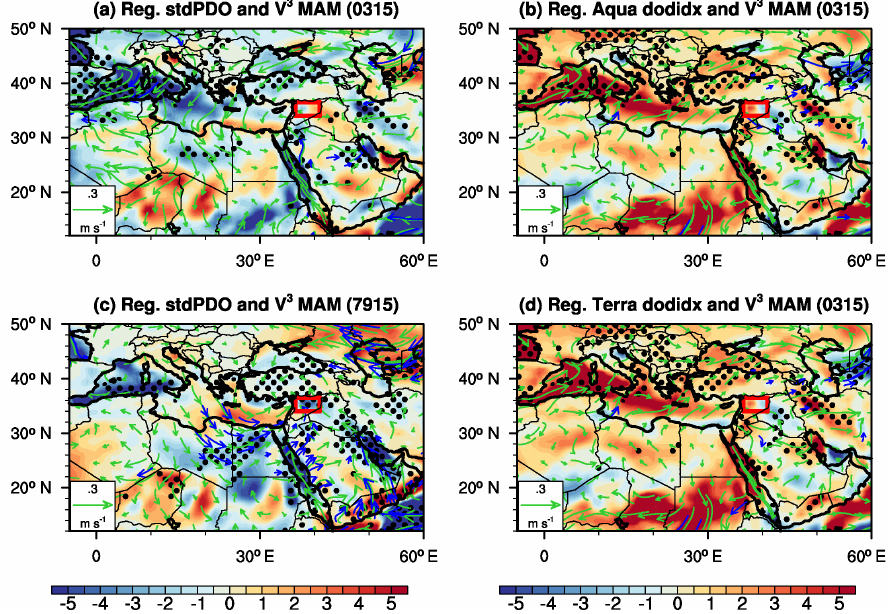
Figure 6. Regressions of ERA-Interim 10m horizontal winds (green vectors; ms − 1 ) and cubic wind speed (shading; m 3 s − 3 ) onto a stan- dardized PDO index (a) from 2003 to 2015 and (c) from 1979 to 2015 and onto the standardized (b) Aqua and (d) Terra DOD indices. Areas where the regressions of the wind speed are significant at the 95% confidence level are dotted and vectors significant at the 90% confidence level are plotted in blue ( t